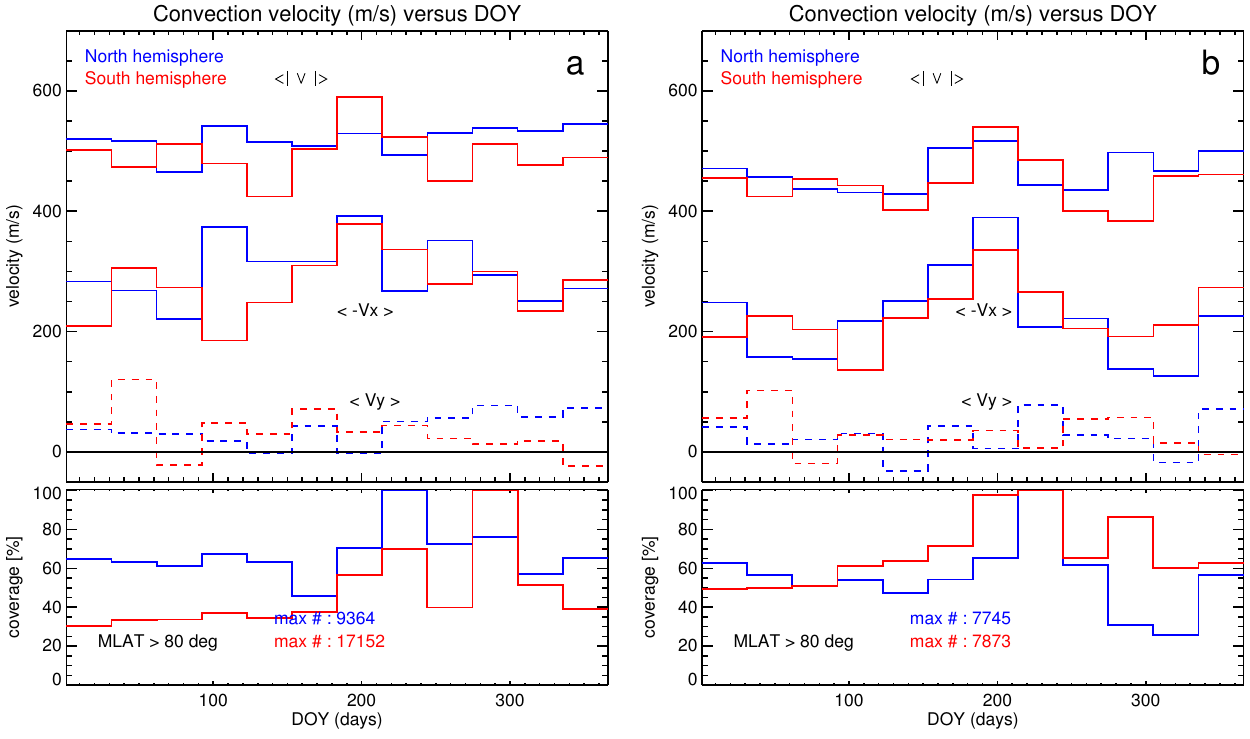
Fig. 11. Average convection velocity variations versus Day of the Year (DOY) (or seasonal dependencies) for the Northern (blue curves) and Southern Hemisphere (red). Left (a) : using all data points of our data set. Right (b) : using a filtered data set with D st > − 30nT only (quiet conditions). The bottom panels illustrate the data coverage of the 12 equally sized steps corresponding to approximately monthly resolution.